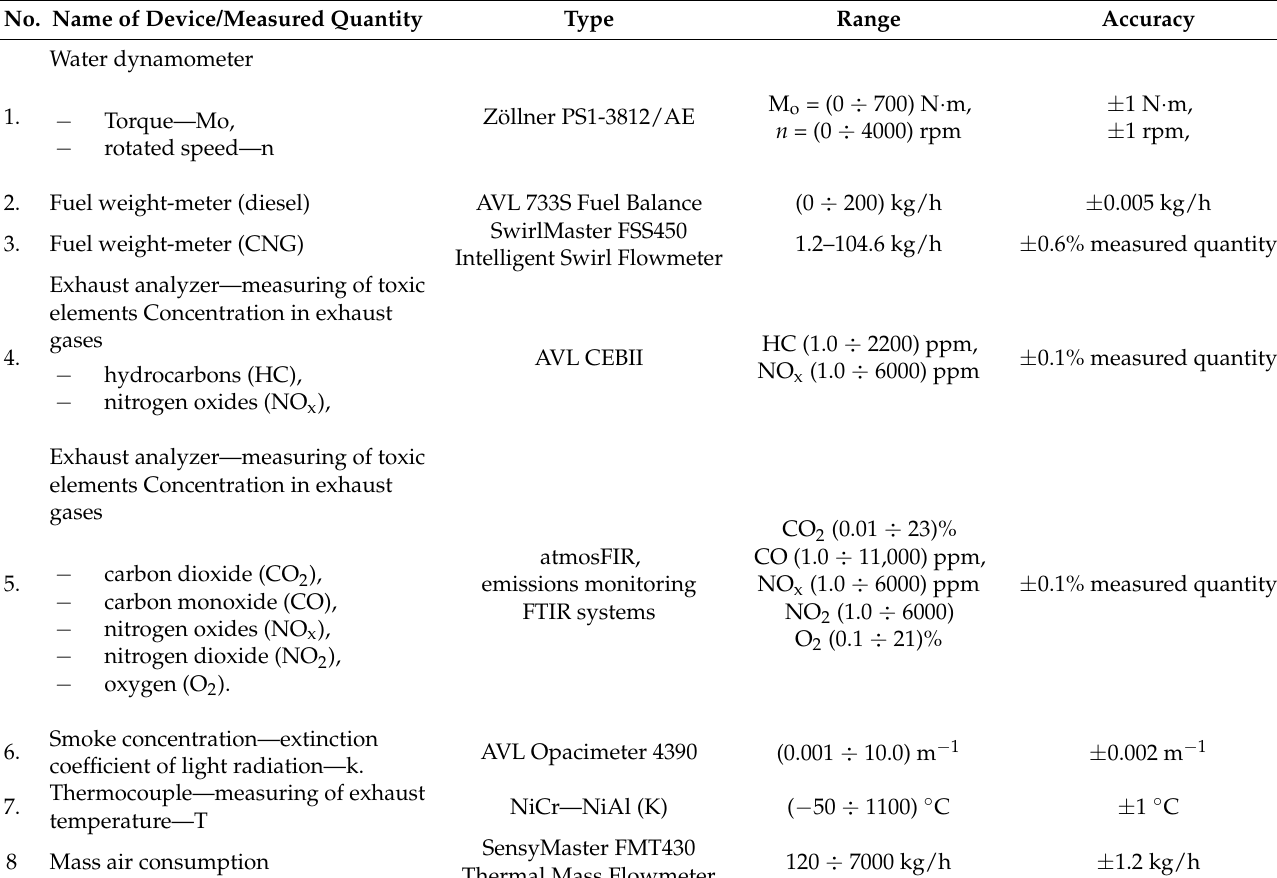
Table 1. List of investigation equipment used during the